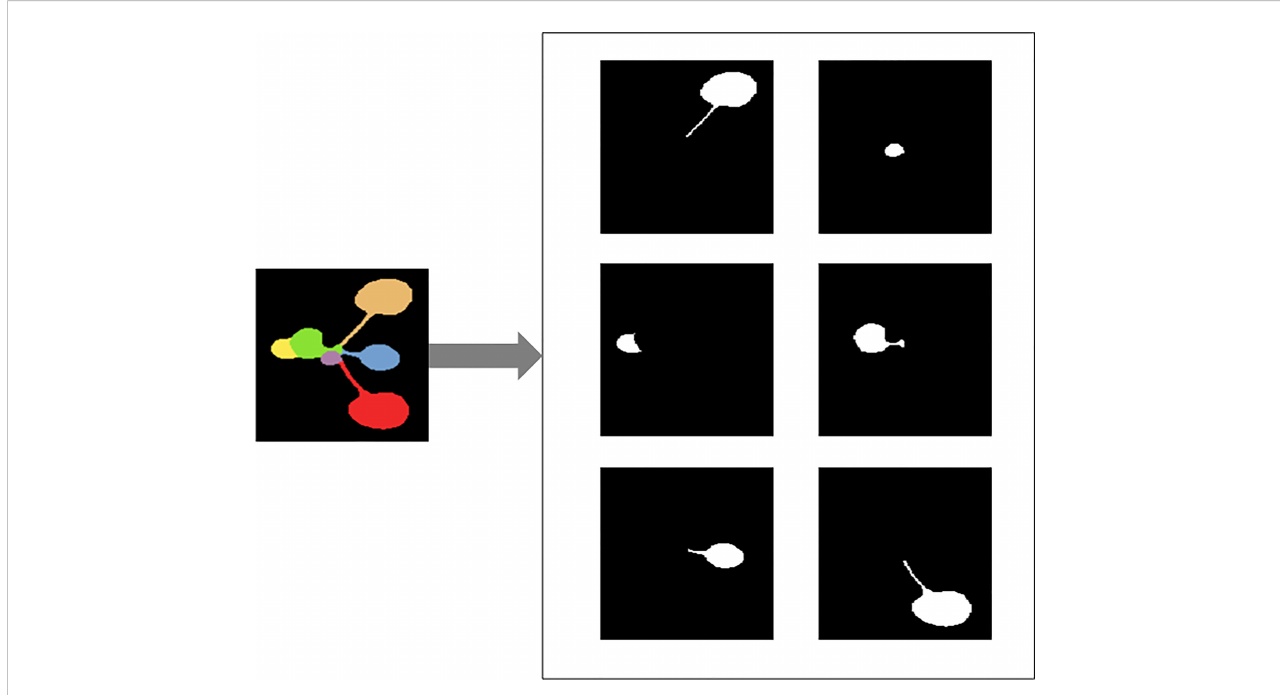
FIGURE 3 Illustration of converting color image of Arabidopsis thaliana to black and white images for each